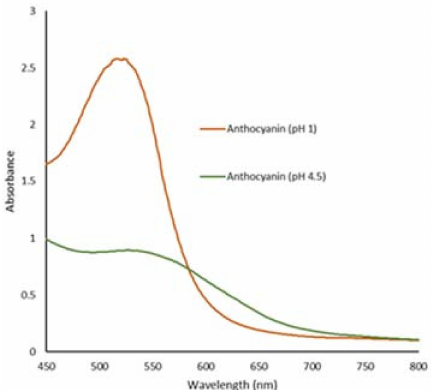
Figure 1. UV-Vis spectra of pH-differential of anthocyanin at pH 1 and pH